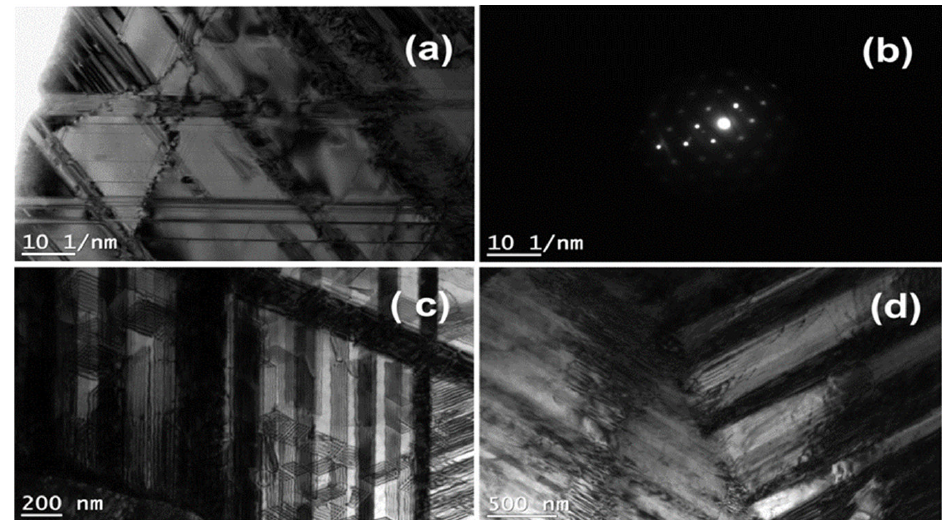
Figure 10. TEM observation of Fe–Mn–Si–Cr alloy processed by the HSHPT method with different degrees of deformation: ( a ) 1.53 strain, ( b ) SAED of ( a ), and ( c , d ) 1.71 strain, adapted with permission from [73], 2022, Trans Tech Publications, Ltd.